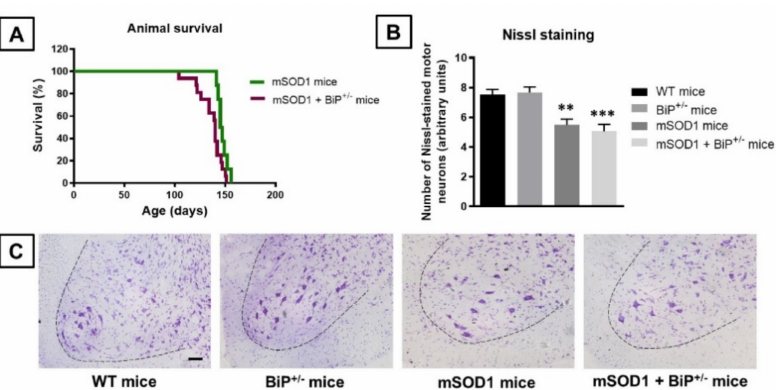
Figure 2. Analysis of animal survival (panel ( A )) and of the number of Nissl-stained motor neurons (panel ( B )), including representative images (panel ( C ); scale bar = 100 µ m), in the lumbar ventral horn (marked with a dotted line) of the spinal cord in mSOD1 transgenic and wild-type male mice with normal or partial ablation of the BiP protein. In the case of Nissl staining, values are means ± SEM of 5–7 animals per group and were assessed by one-way analysis of variance followed by the Tukey test (** p < 0.01, *** p < 0.005 vs. WT or BiP +/ − mice). Data for animal survival were presented as a Kaplan-Meier plot and assessed by Chi-square